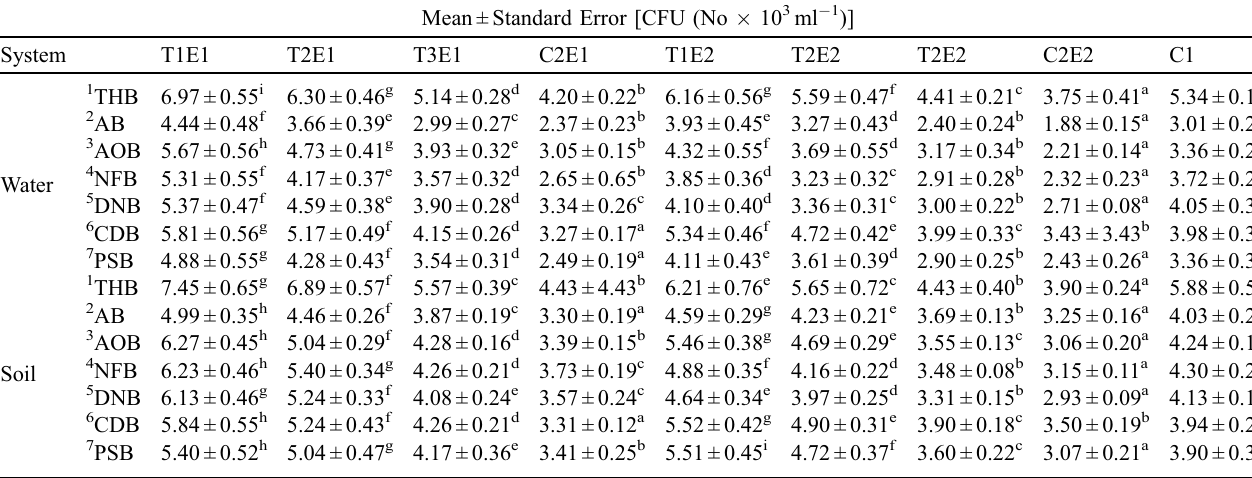
Table 7. Microbial populations in the both experiments E1 and